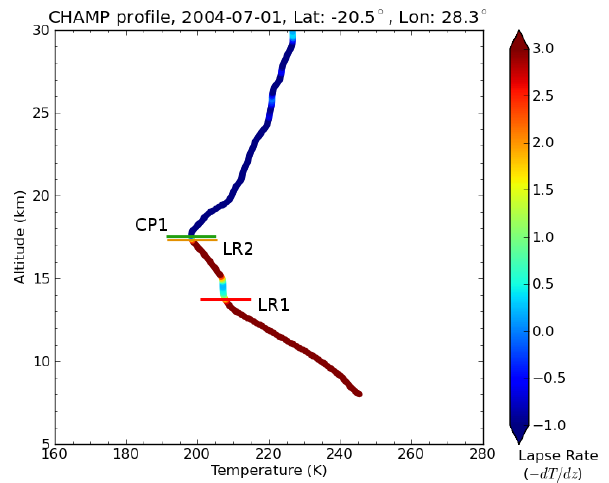
Figure 1. CHAMP temperature profile colored according to its lapse rate. Horizontal bars indicate the lowest (first) lapse rate tropopause (LR1), second lapse rate tropopause (LR2), and the lo- cal minimum of the profile, the cold point tropopause (CP1). Note the decrease in temperature above LR1, fulfilling the requirement for a second tropopause (lapse rate greater than 3 ◦ Ckm − 1